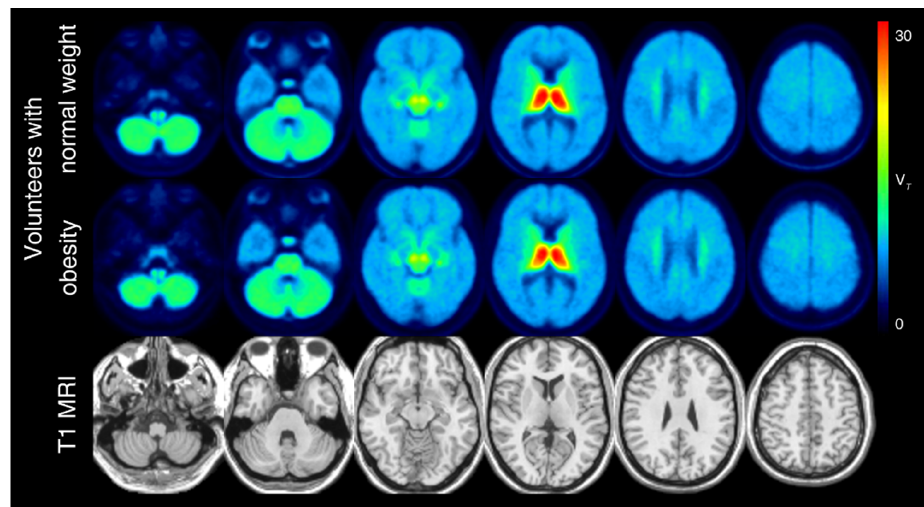
Figure 4. The ( ‐ ) ‐ [ 18 F]flubatine average total distribution volume of all normal ‐ weight volunteers (first row) and volunteers with obesity (second row) using positron emission tomography co ‐ reg ‐ istered to T1 (third row) magnetic resonance imaging.